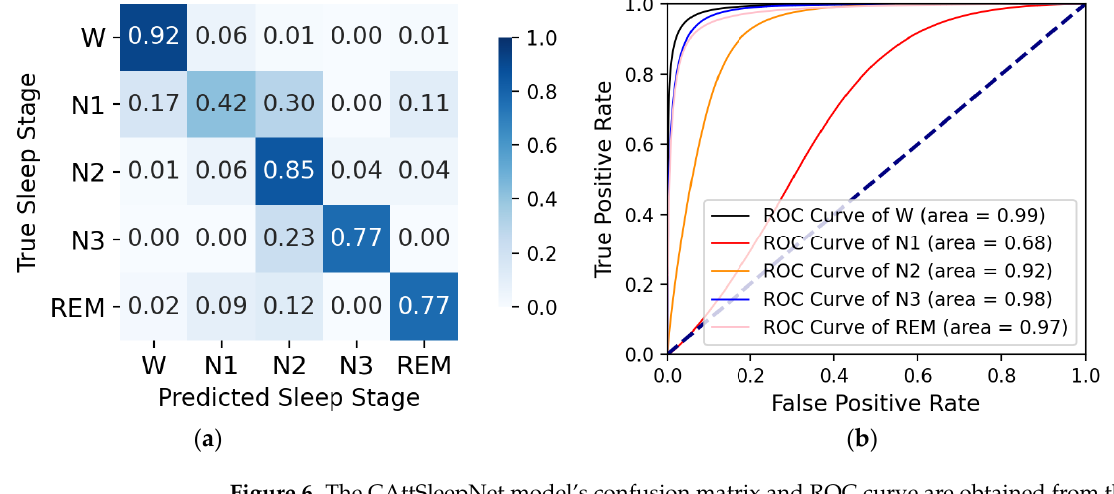
Figure 6. The CAttSleepNet model’s confusion matrix and ROC curve are obtained from the Fpz-Cz